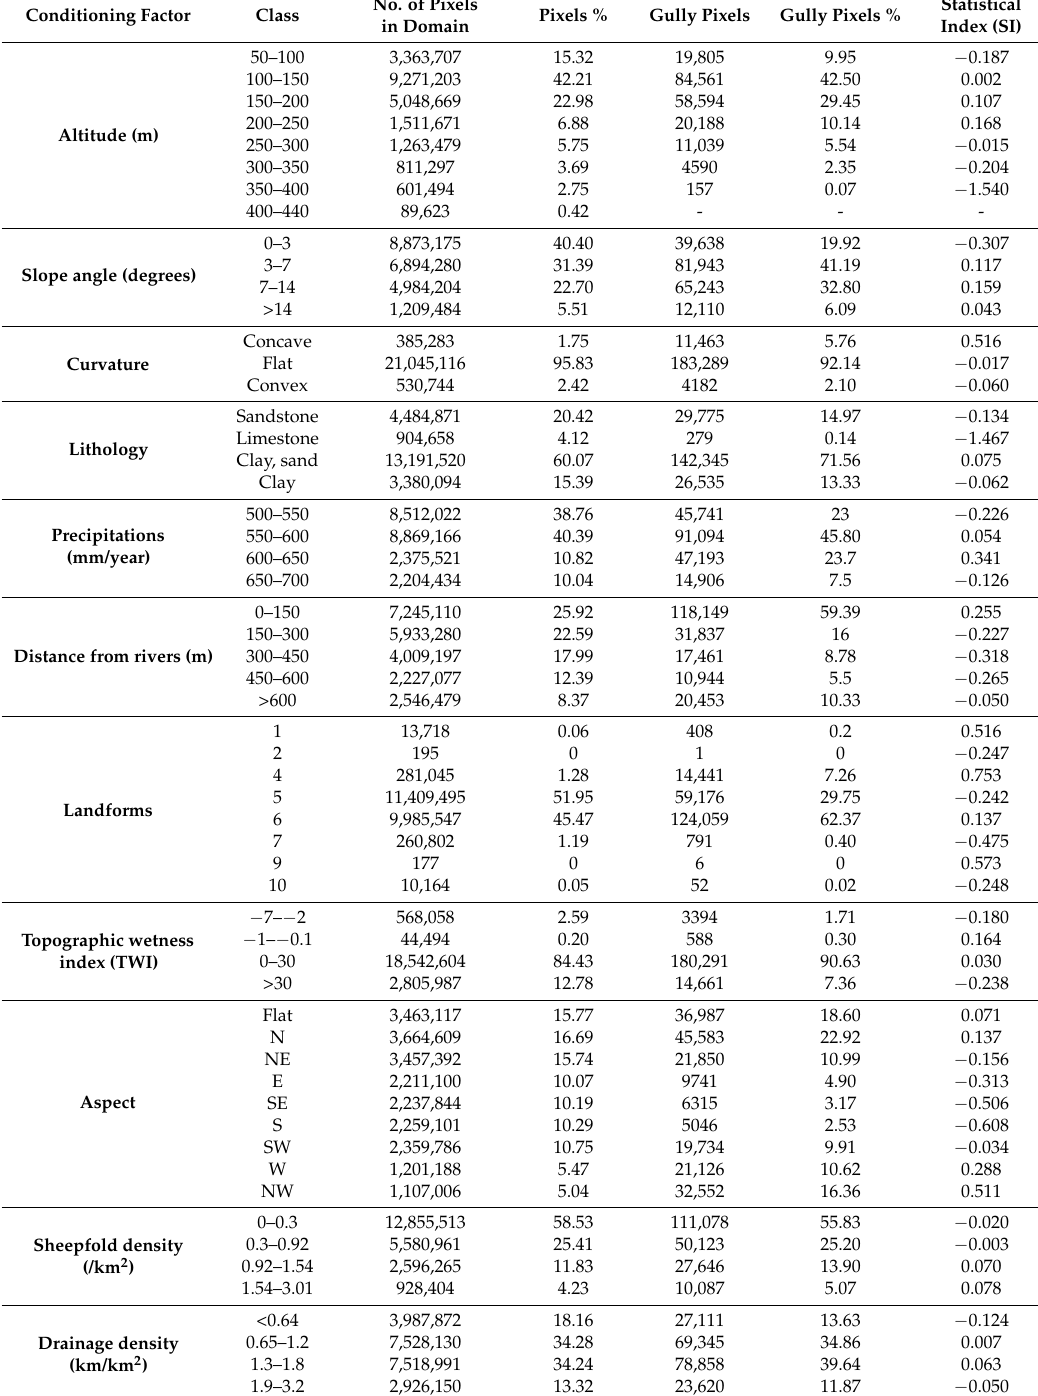
Table 1. Statistical index values for the conditioning